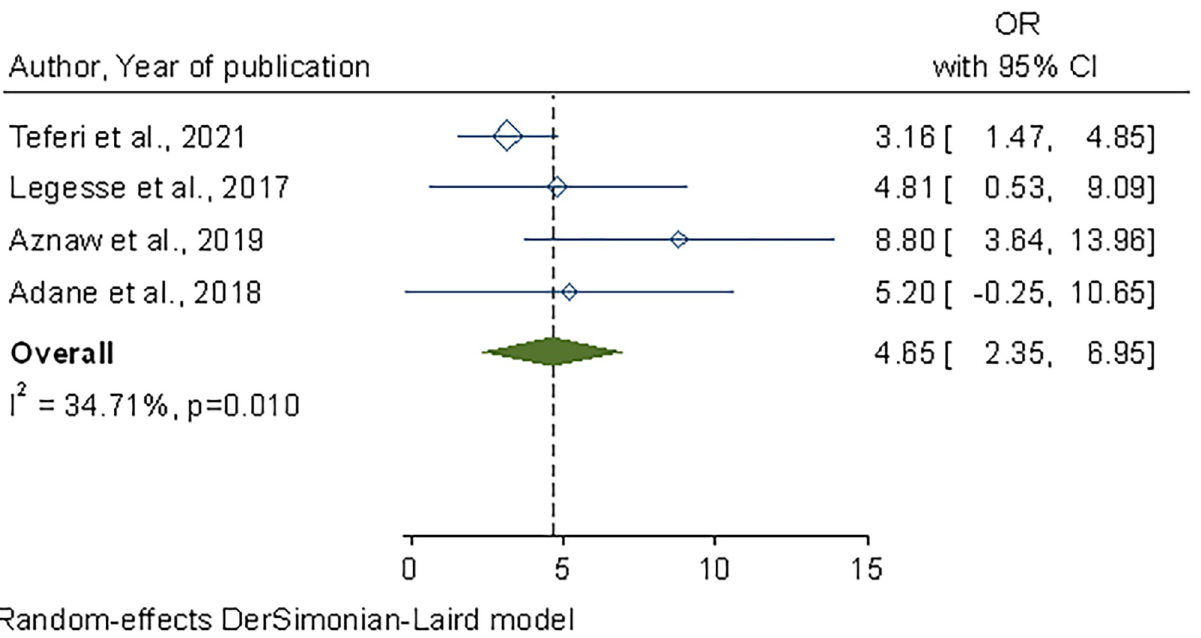
Fig 7. Forest plot of the association between availability of an on-site water storage facility and safe food handling practices in Ethiopia, 2022.